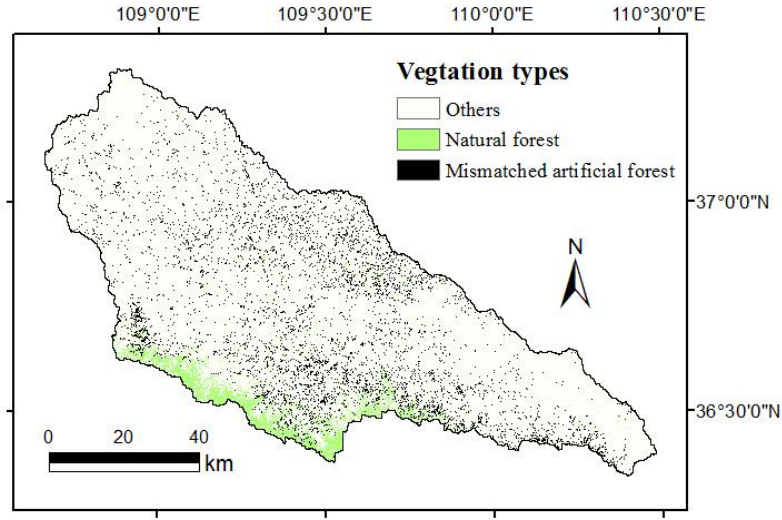
Figure 4. Distribution of mismatched planted forest (the actual forest beyond the boundary of potential natural forest) and natural forest in the Yanhe River catchment. natural forest) and natural forest in the Yanhe River